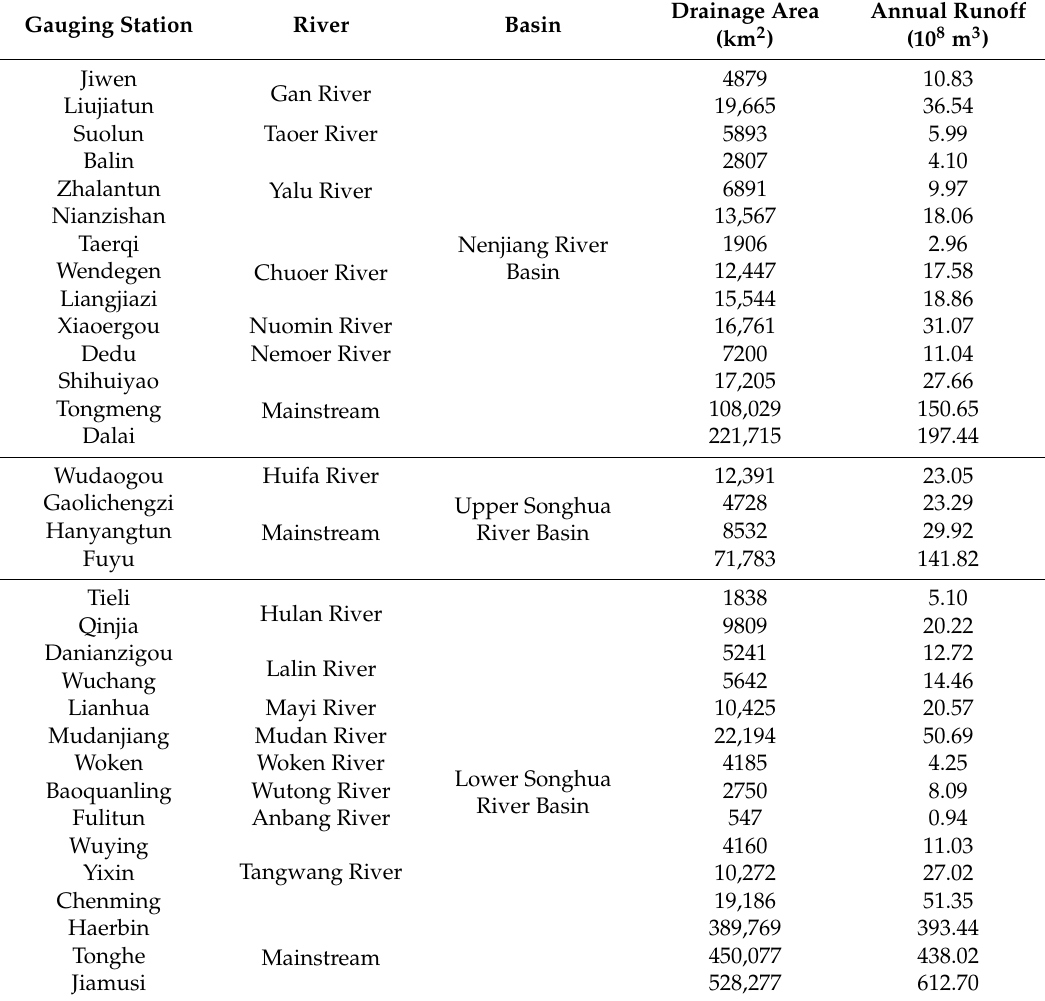
Table 1. Summary of main gauging stations and hydrological characteristics in the Songhua River Basin, Northeast